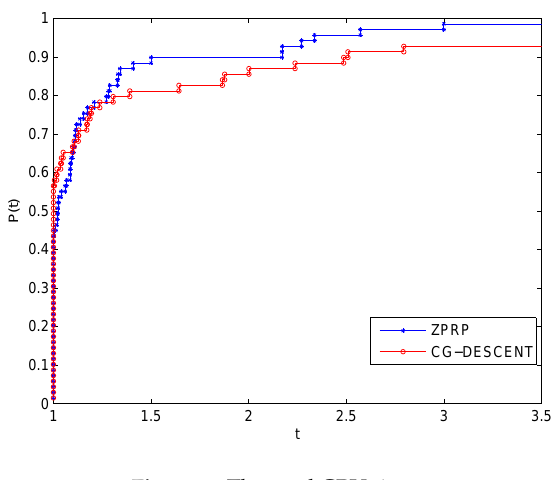
Figure 3. The total CPU time.